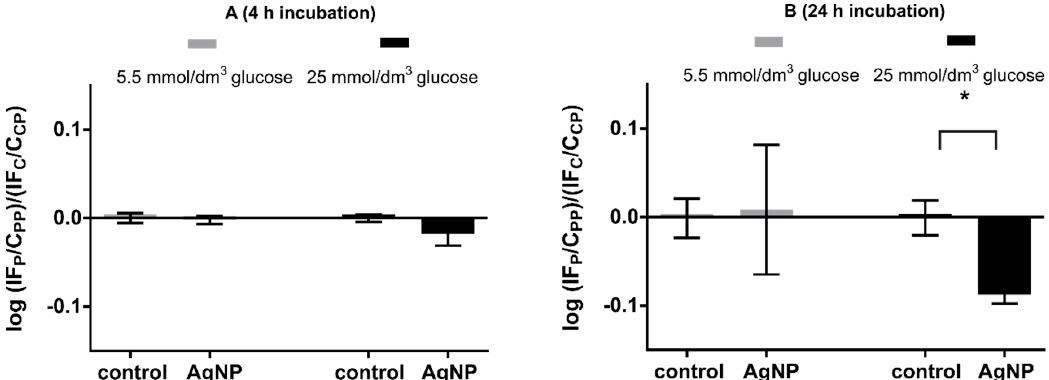
Figure 6. Logarithm of the fluorescence intensity ratio of protein-bound fluorescamine for cells exposed and nonexposed to nanoparticles (control). Fluorescence was normalized with respect to the protein content. Statistical analysis was performed using Student’s t-test, n = 3. The concentration of silver nanoparticles was 25 µ g / cm 3 . Cells were collected after 4 h incubation ( A ) and after 24 h incubation, ( B ) with silver nanoparticles. * denotes a statisticcally significant di ff